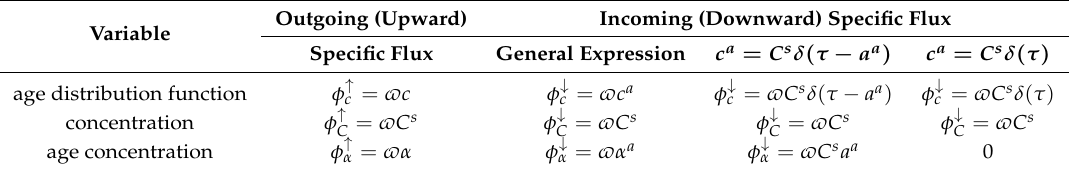
Table 1. Outgoing and incoming specific fluxes (ratio of a flux to the water density) at the water–air interface for the age distribution function ( φ ↑ , ↓ c ), the concentration ( φ ↑ , ↓ ), and the age C concentration ( φ ↑ , ↓ α ). As for the downward flux, the general expression and two simplified ones are taken into consideration, which consists in assuming that all the incoming gas particles have the same age, a a (fourth column), and that this age is zero (fifth column). Outgoing (Upward) Incoming (Downward) Specific Flux Variable